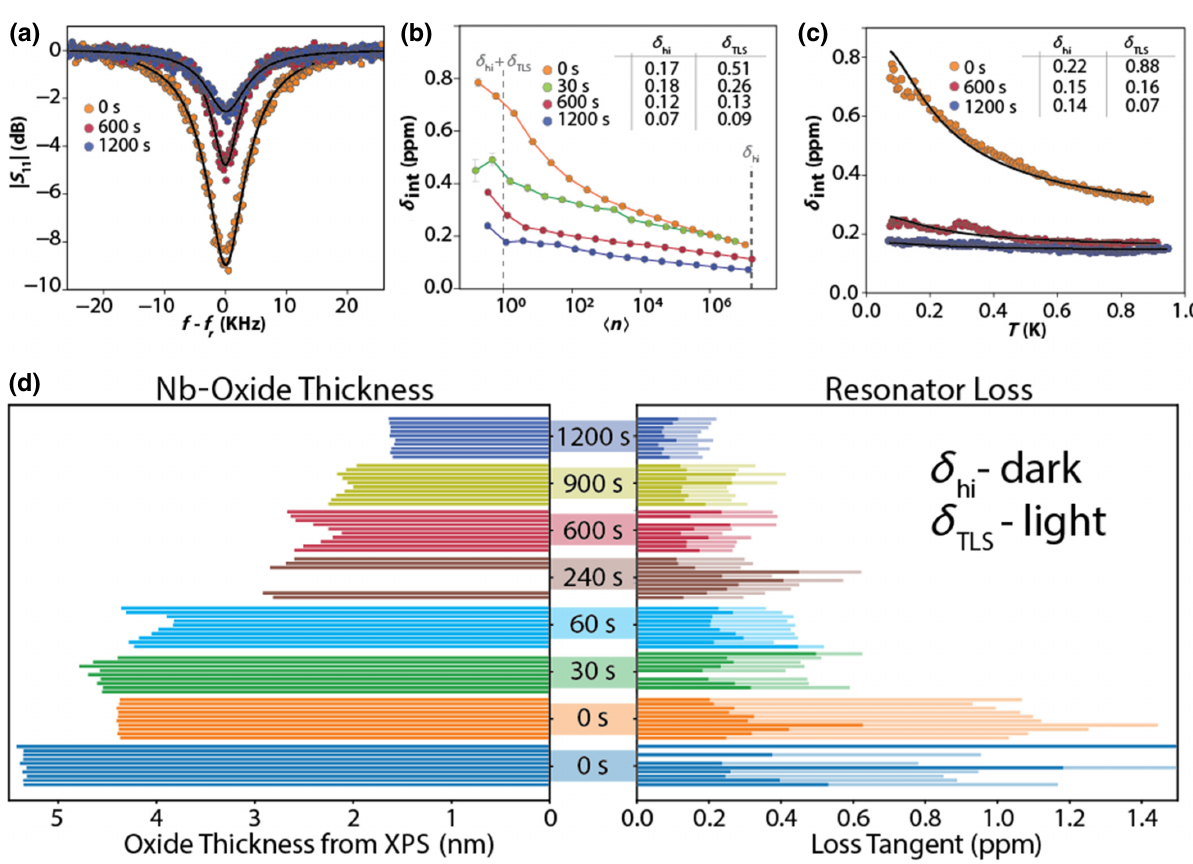
FIG. 6. (a)–(c) Microwave reflectometry comparing the lowest-loss resonators from unetched (orange), 600 s (red) and 1200 s (blue) etched chips. (a) Single-photon | S 11 | reflectometry. The decreased peak depth at resonance shows reduced loss. (b) The resonator intrinsic loss δ int as a function of the photon number (cid:3) n (cid:4) , decomposed into the 10 7 -photon high-power loss δ hi and the single-photon loss δ hi + δ TLS , as shown by the vertical dashed lines, yielding the values shown in the inset. Etched resonators show reduced losses at all power levels. (c) The temperature-dependent δ int at (cid:3) n (cid:4) ≈ 1 fit to the TLS standard tunneling model (see Appendix H). The inset shows the thermal fitting results. (d) Grouped histograms correlating the resonator loss (right) and the NbO x thickness from XPS (left) for all resonators using the method of (b). The light-colored bars show the TLS loss δ TLS and the darker bars the high-power loss δ hi , so the combined length is the measured single-photon loss. Unetched resonators (results from two different unetched “0 s” reference chips shown in blue and orange) are dominated by TLS losses, while δ TLS and δ hi are similar for etched